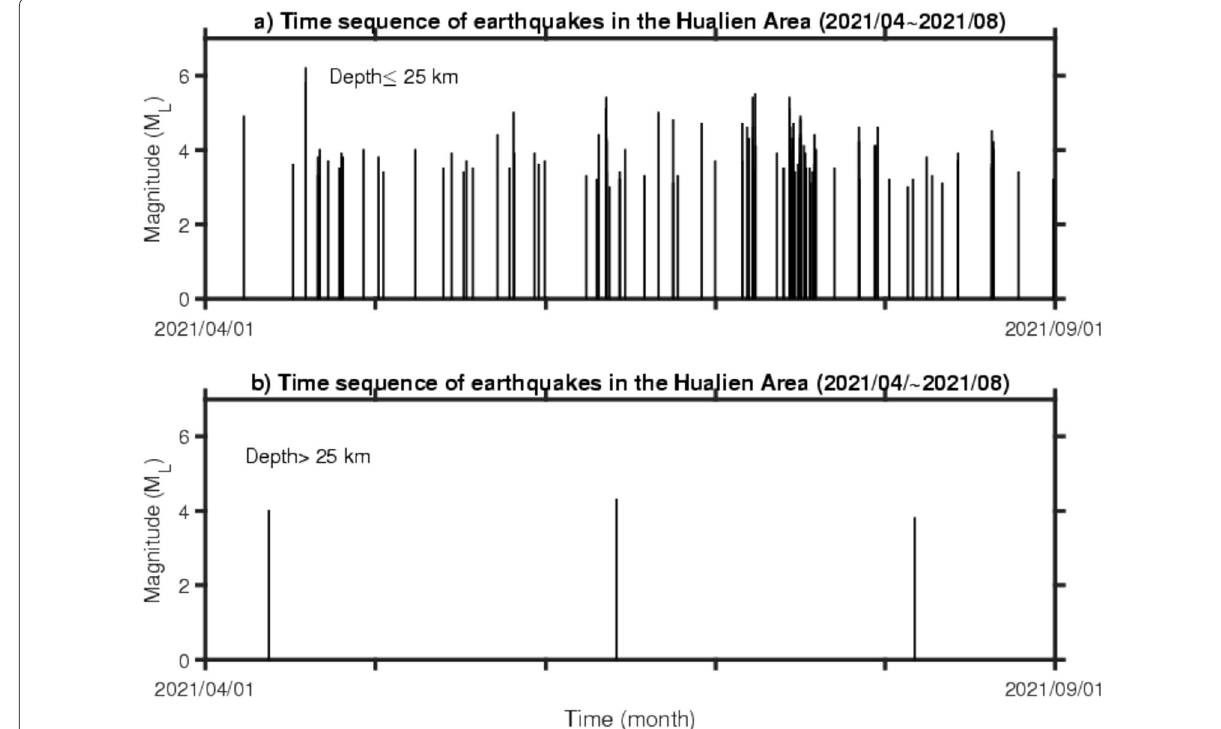
Fig. 4 Time sequences of M L